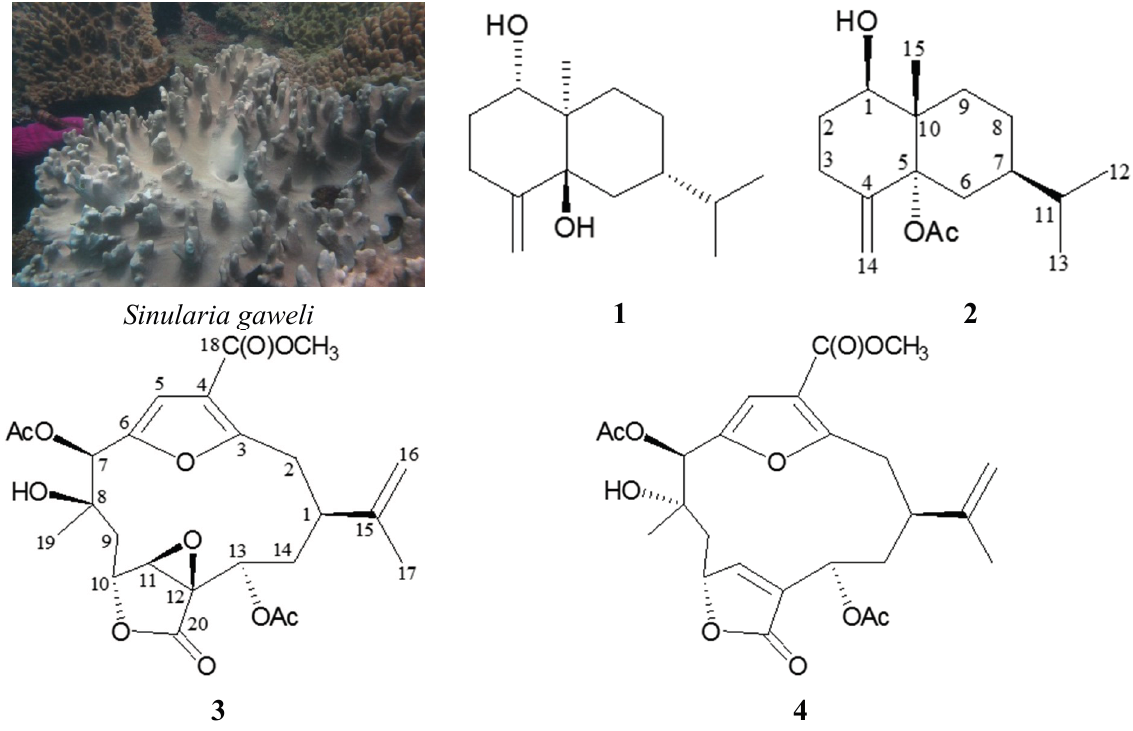
Figure 1. The soft coral Sinularia gaweli and the structures of verticillatol ( 1 ); 5 α -acetoxy- 4(14)-eudesmene-1 β -ol ( 2 ); (–)-leptodiol acetate ( 3 ); and sinulacembranolide A ( 4